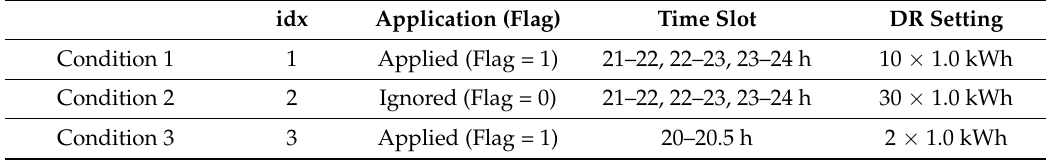
Table 9. DR (Demand Response) operating condition.